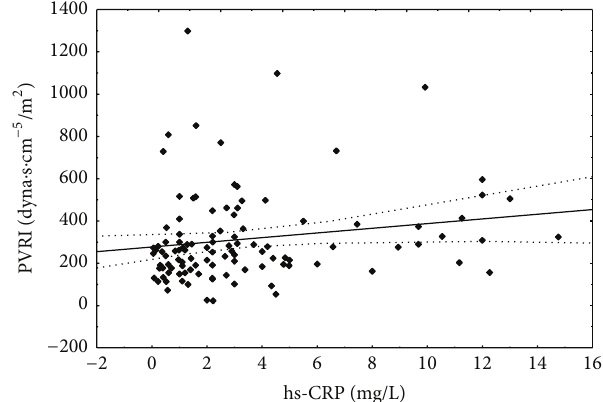
Figure 3: Correlation between uric acid concentration and mean pulmonary artery pressure. Spearman 𝑟 = 0.236 ; 𝑃 < 0.05 .